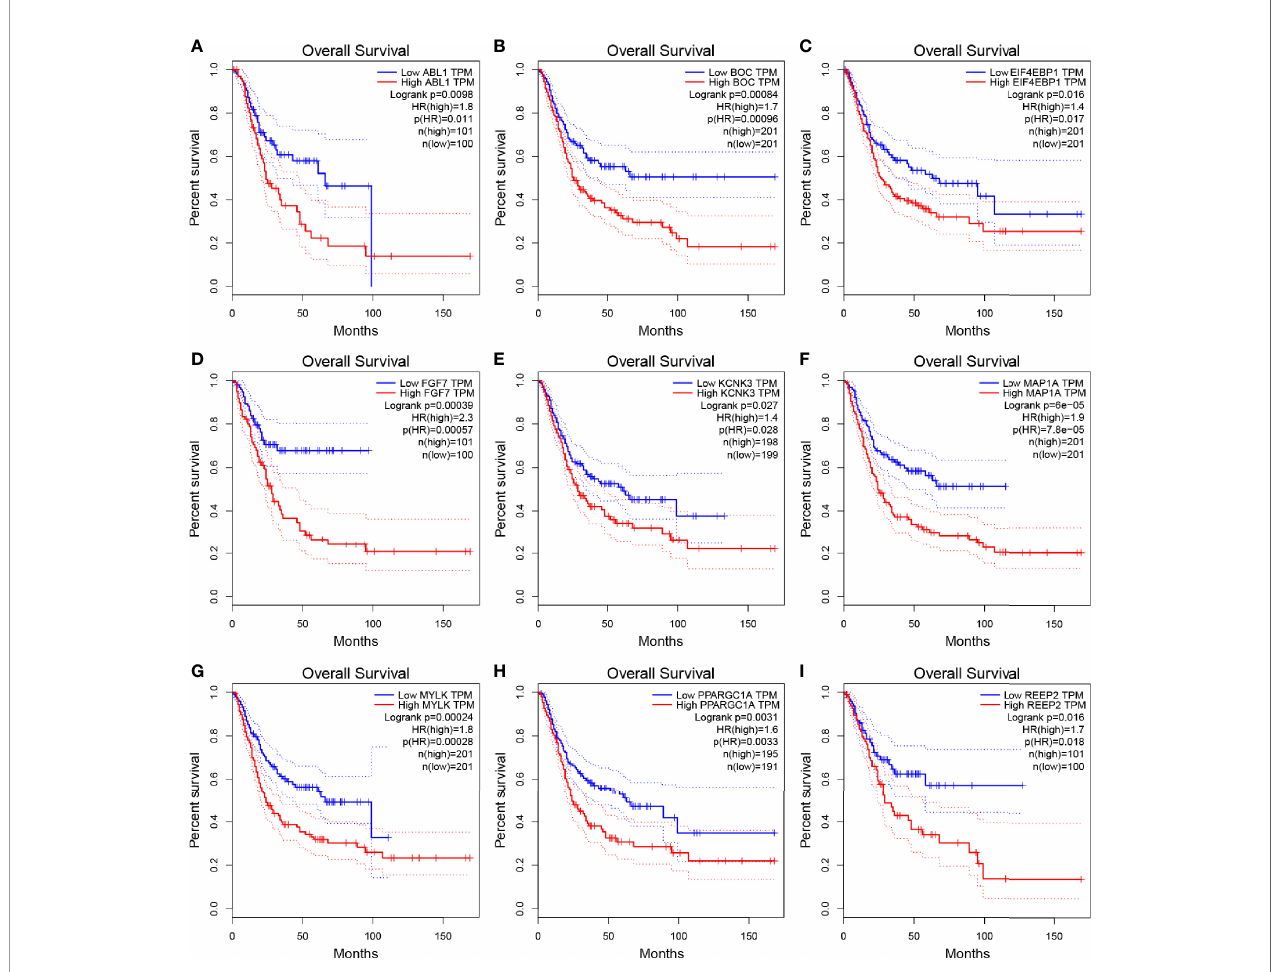
FIGURE 2 | Kaplan – Meier overall survival (OS) curves for BLCA patients assigned to groups of high and low expression level based on the nine genes, respectively. ( A – I show the results of ABL1, BOC, EIF4EBP1, FGF7, KCNK3, MAP1A, MYLK, PPARGC1A, REEP2,